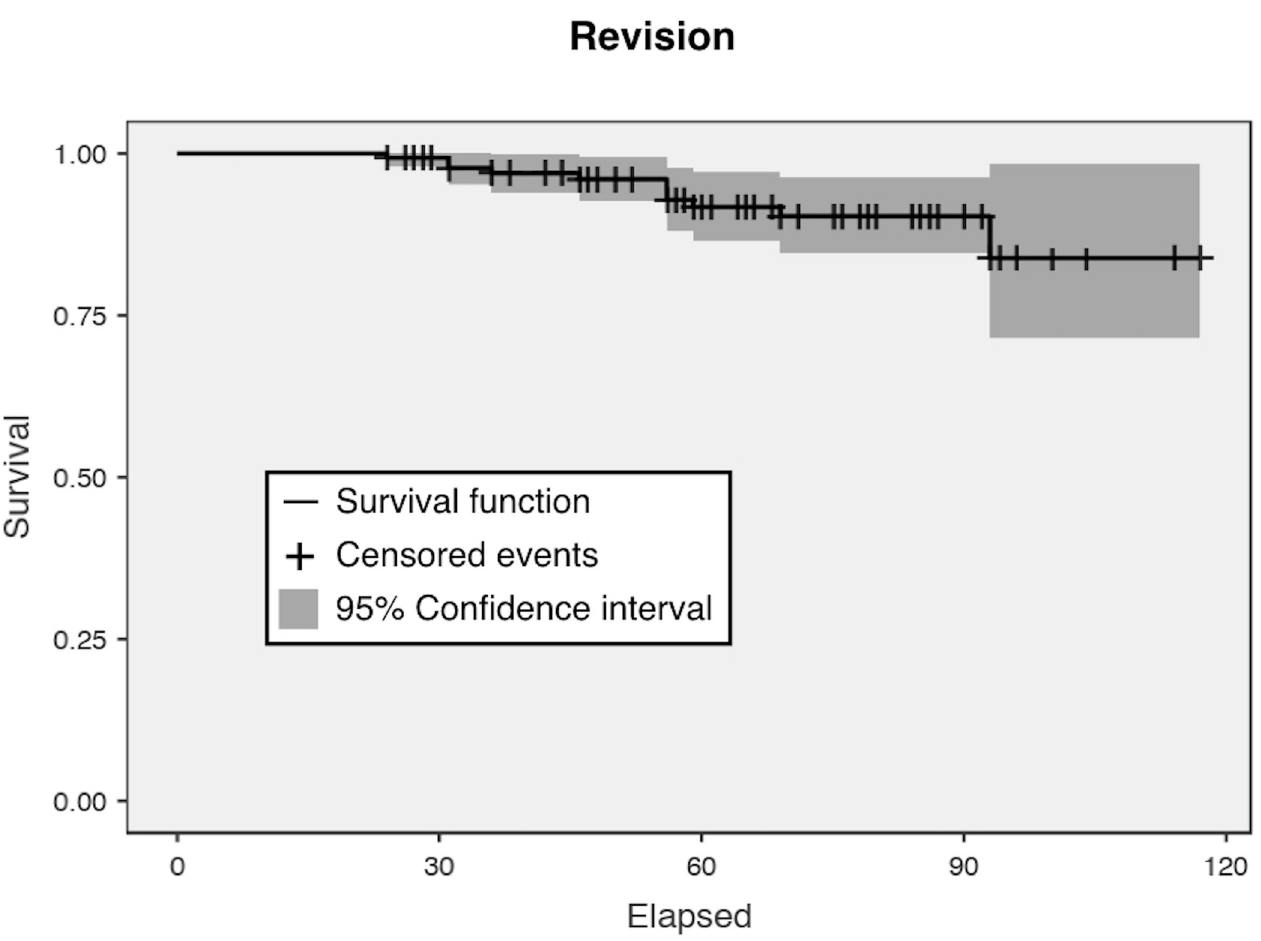
Fig 5. Kaplan-Meier survival function for the survival of the population (n = 148) free of revision for any cause. The 95% confidence interval is shown in grey.